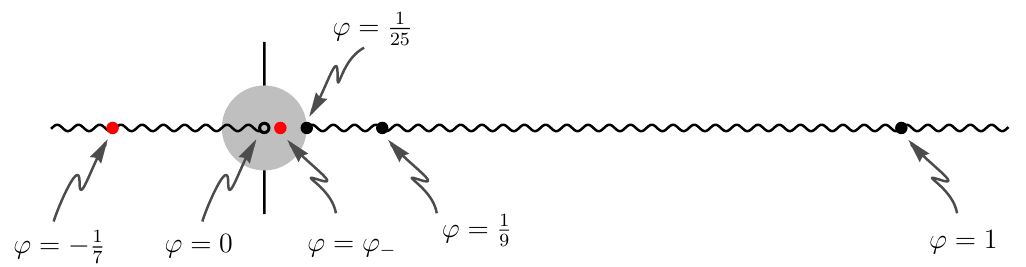
. There 25 is due to the singularities 25 and ’ = ’ (cid:0) . The 7